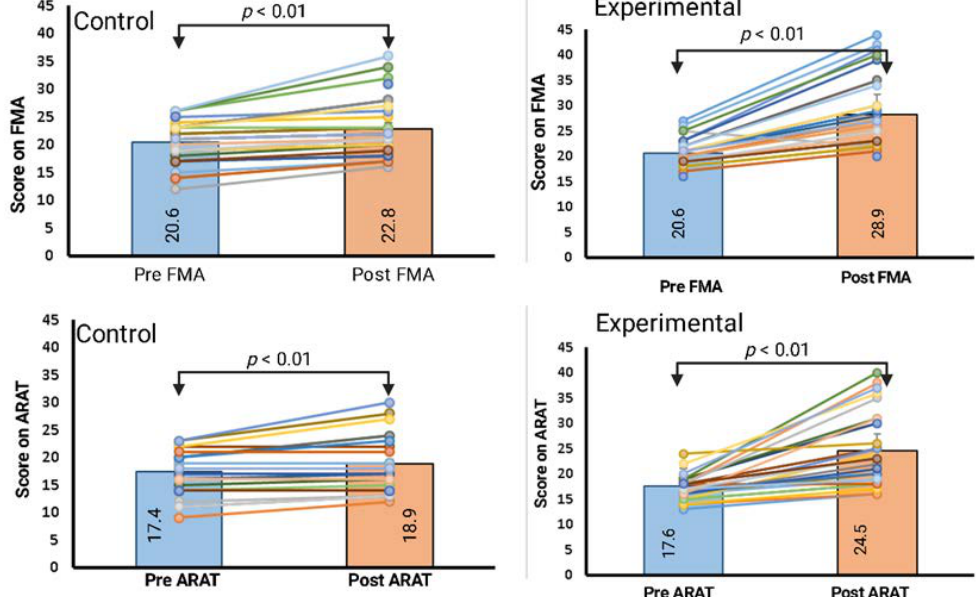
Figure 4. Pretest/post-test comparison of participants’ individual scores between experimental and control groups. ARAT; Action Research Arm Test, FMA; Fugl-Meyer